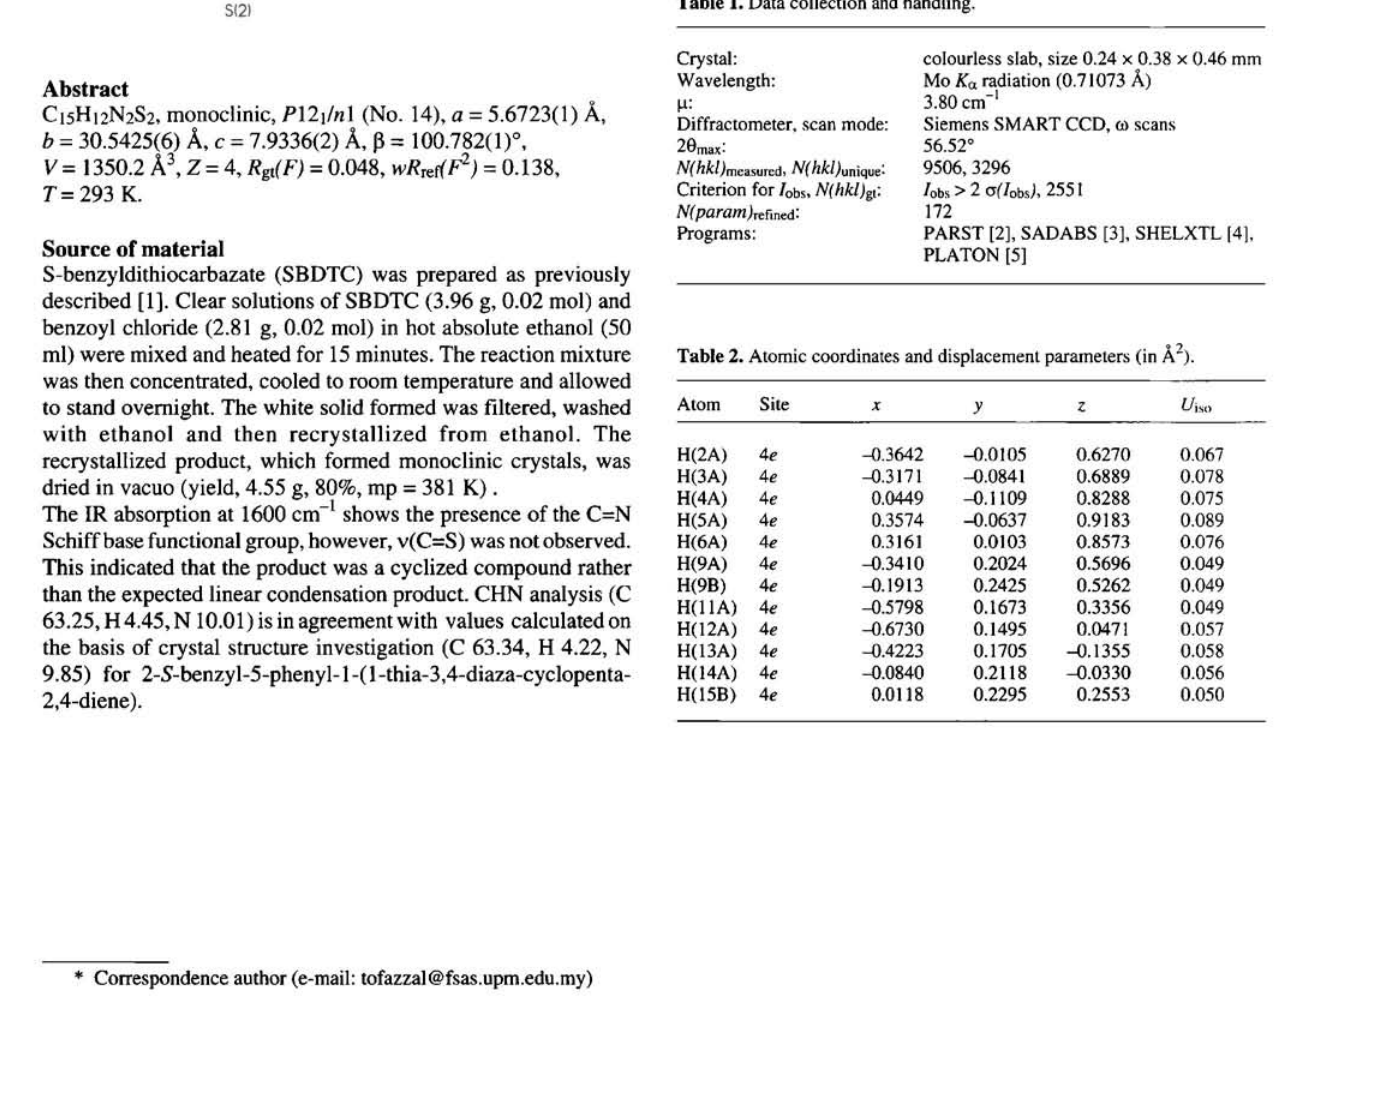
Table 1. Data collection and handling.